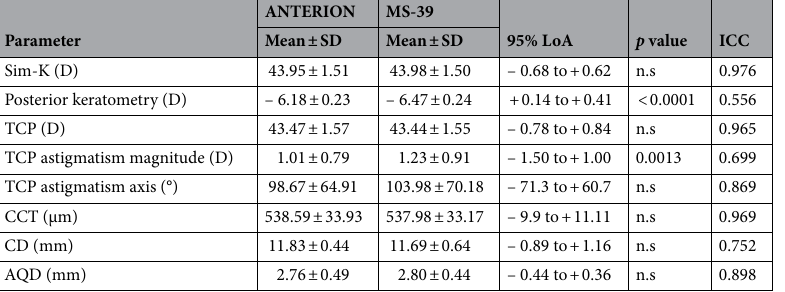
Table 3. Comparison between the mean values measured by the ANTERION and by the MS-39. LoA limits of agreement, ICC Intraclass correlation coefficient (between ANTERION and MS-39), Sim-K simulated keratometry, TCP total corneal power, CCT central corneal thickness, CD corneal diameter, AQD aqueous depth.